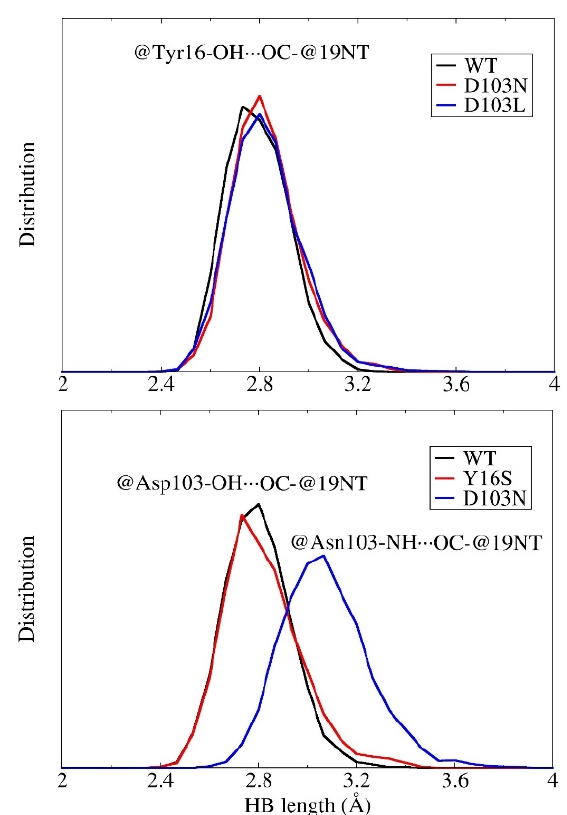
Figure 6. Distribution of hydrogen bond lengths ( A ) between the O atom of Tyr16 (@Tyr16-OH) and the O atom of the C=O group in 19-NT (OC-@19NT), ( B ) between the O atom of Asp103 (@Asp103-OH) and the O atom of the C=O group in 19-NT (OC-@19NT) and between the N atom of Asn103 (@ASN103-NH) and O atom of the C=O group in 19-NT (OC-@19NT).